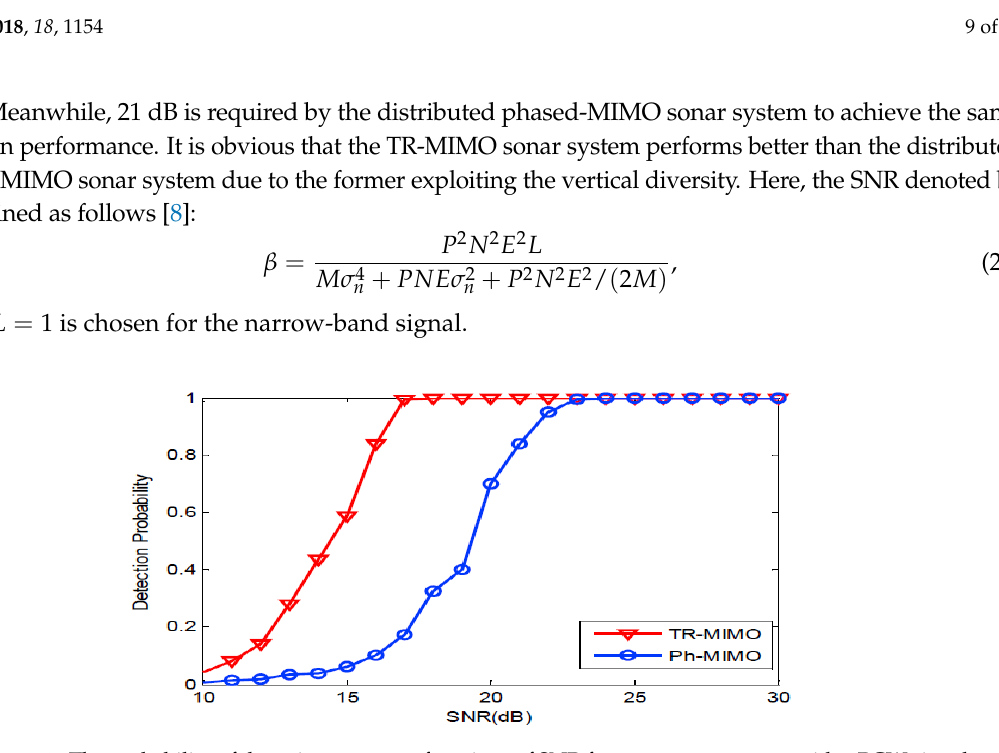
Figure 4. The probability of detection curves as functions of SNR for two sonar systems with a PCW signal.